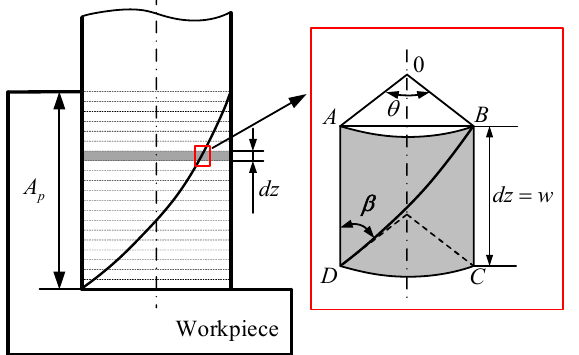
Figure 12. Schematic diagram for the micro-blade of end mills.